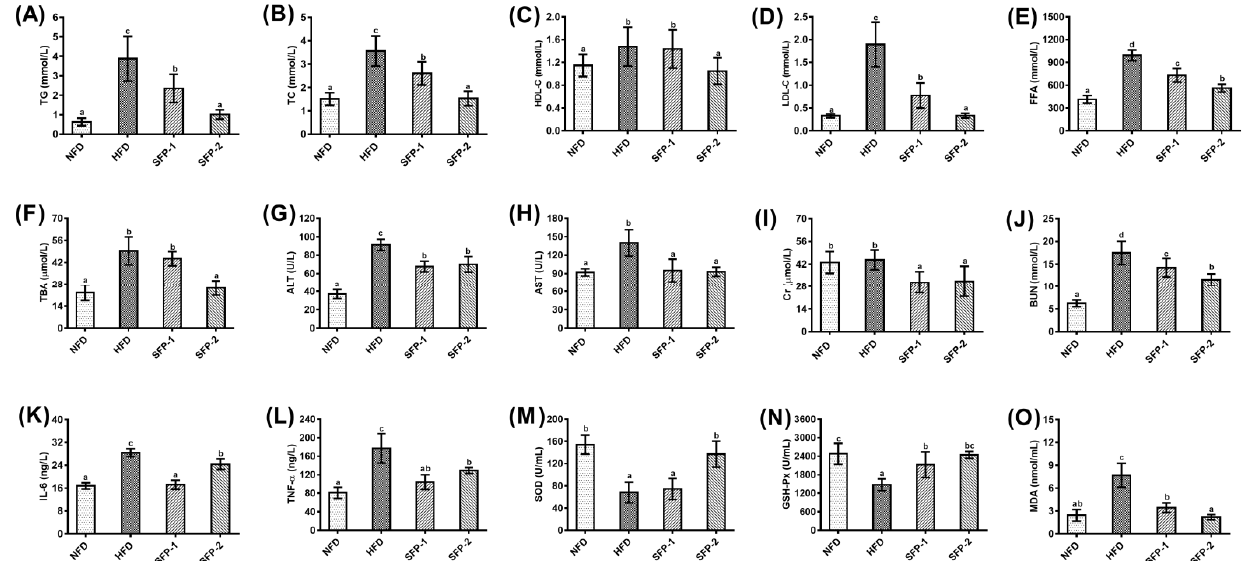
Figure 3. Effects of SFPs on serum profiles in diabetic rats: TG ( A ), TC ( B ), HDL-C ( C ), LDL-C ( D ), FFA ( E ), TBA ( F ), ALT ( G ), AST ( H ), Cr ( I ), BUN ( J ), IL-6 ( K ), TNF- α ( L ), SOD ( M ), GSH-Px ( N ) and MDA ( O ). The different letters represent significant difference ( p <